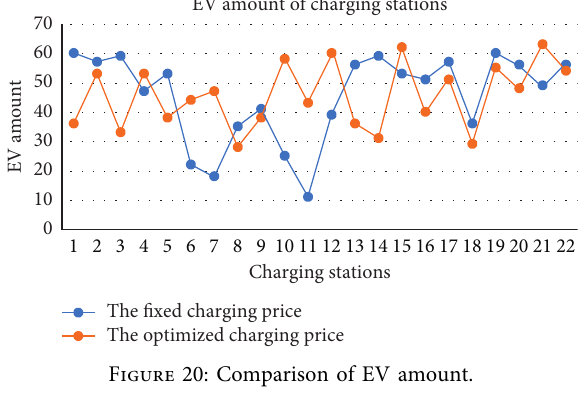
Figure 20: Comparison of EV amount.